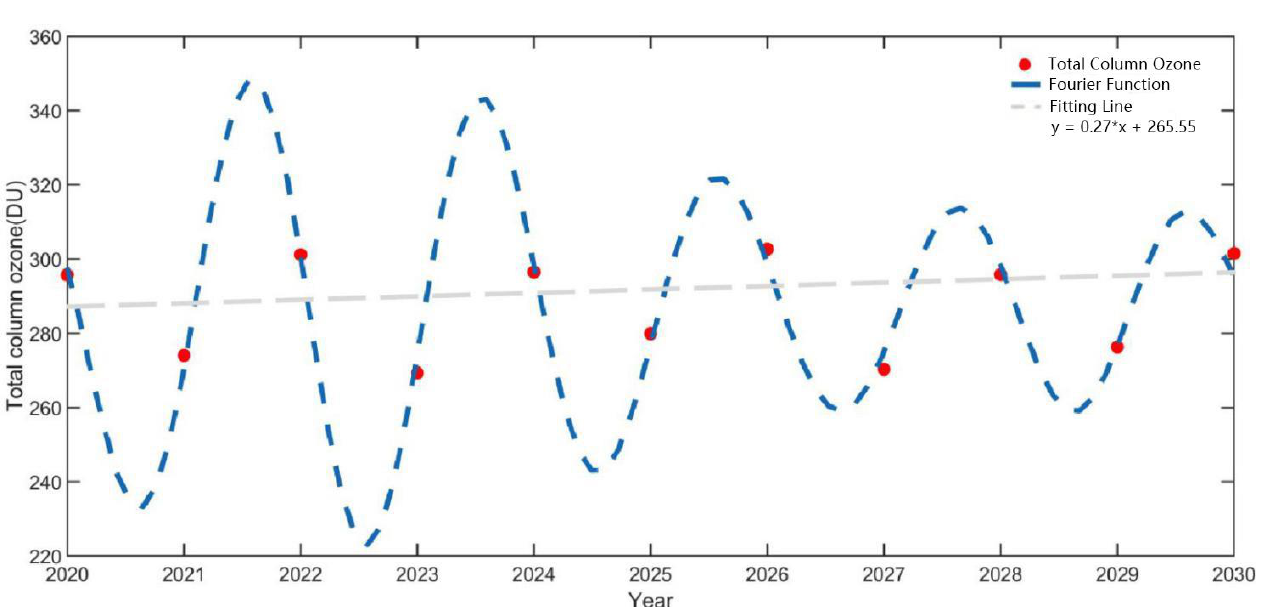
Figure 7. The line chart of the TCO prediction results over the Yangtze River Delta Urban Agglom- erations during 2020 – 2030. The red points stand for the TCO prediction results over the study area in each corresponding year. The dotted blue line shows the fitting line of the TCO predicted results based on the constructed Fourier function. The solid gray line is the linear fitting line for the TCO prediction results, and its linear fitting function is shown in the upper-right of the figure. Note: Only the data corresponding to integer years (such as 2020, 2025, 2027, etc.) are meaningful and accurate data, and there is little reference in the other values and the fluctuance patterns of the fitting lines. For more precise interannual changes, please refer to Figure A8.